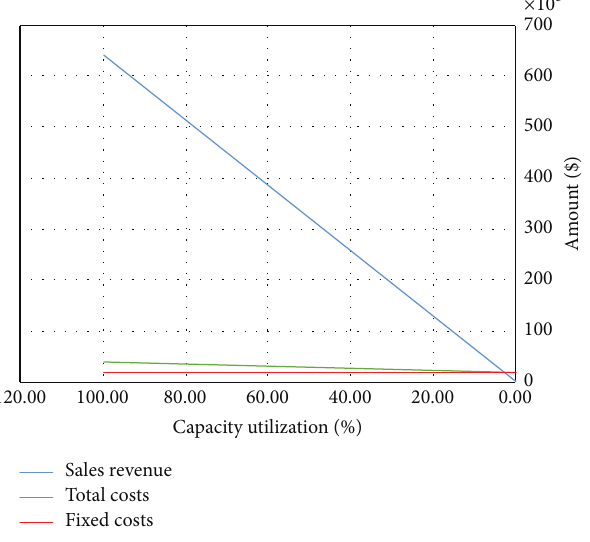
Figure 4: Break-even analysis for Model #2.